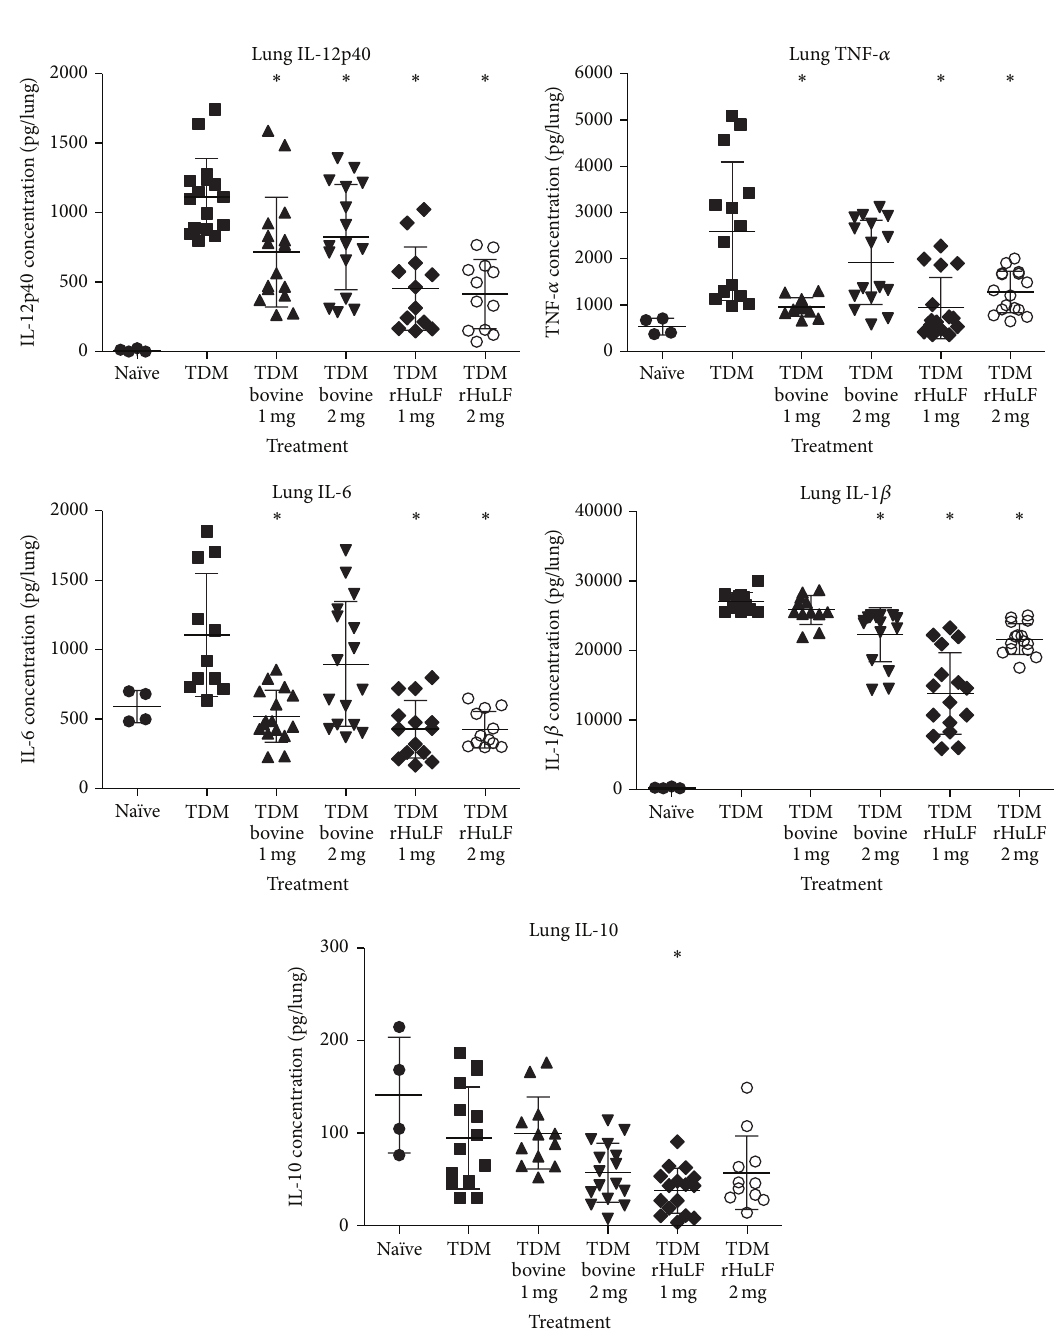
Figure 3: Proinflammatory cytokines in lungs are reduced in lactoferrin-treated mice after challenge with TDM. BALB/c mice were challenged with 25 𝜇 g TDM in a water-in-oil emulsion. Bovine or recombinant human lactoferrin (1 or 2 mg) was orally administered at 4 and 6 days after TDM challenge. Methods of TDM induction are described elsewhere [38, 101]. Lungs were isolated on day 7 after TDM challenge; cytokines were assessed by ELISA; values are shown per lung for individual mice. ∗ 𝑝 < 0.05 compared to the TDM emulsion alone treated